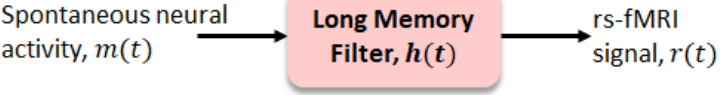
Figure 2. Linear FIP model of rs-fMRI